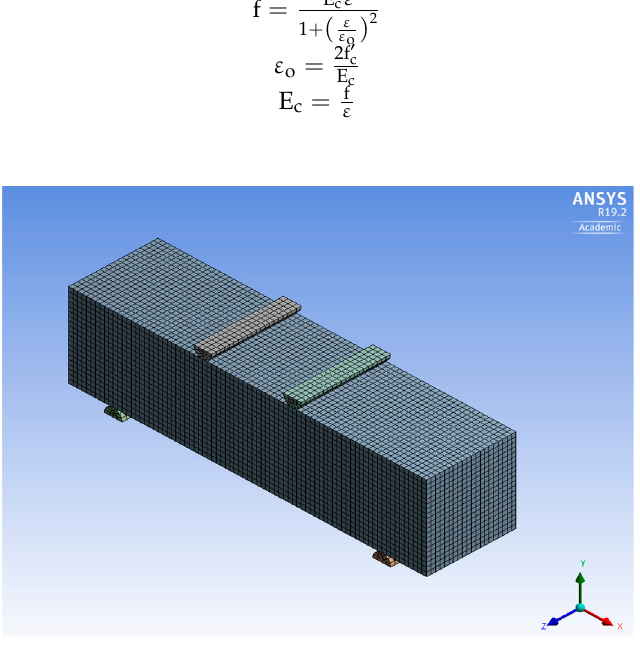
Figure 9. Schematic of Solid65 element.